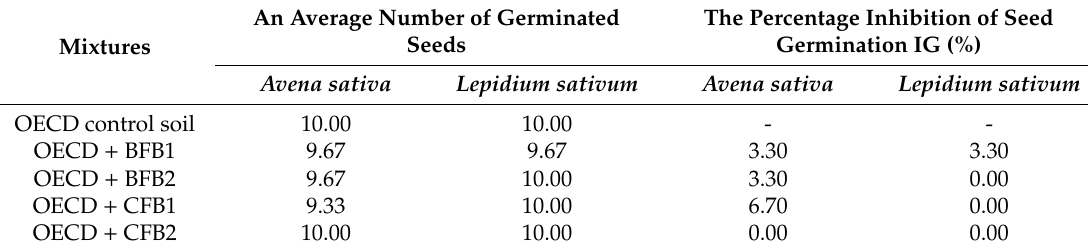
Table 4. Percentage inhibition of the seed germination, IG, calculated based on the average number of germinated seeds.